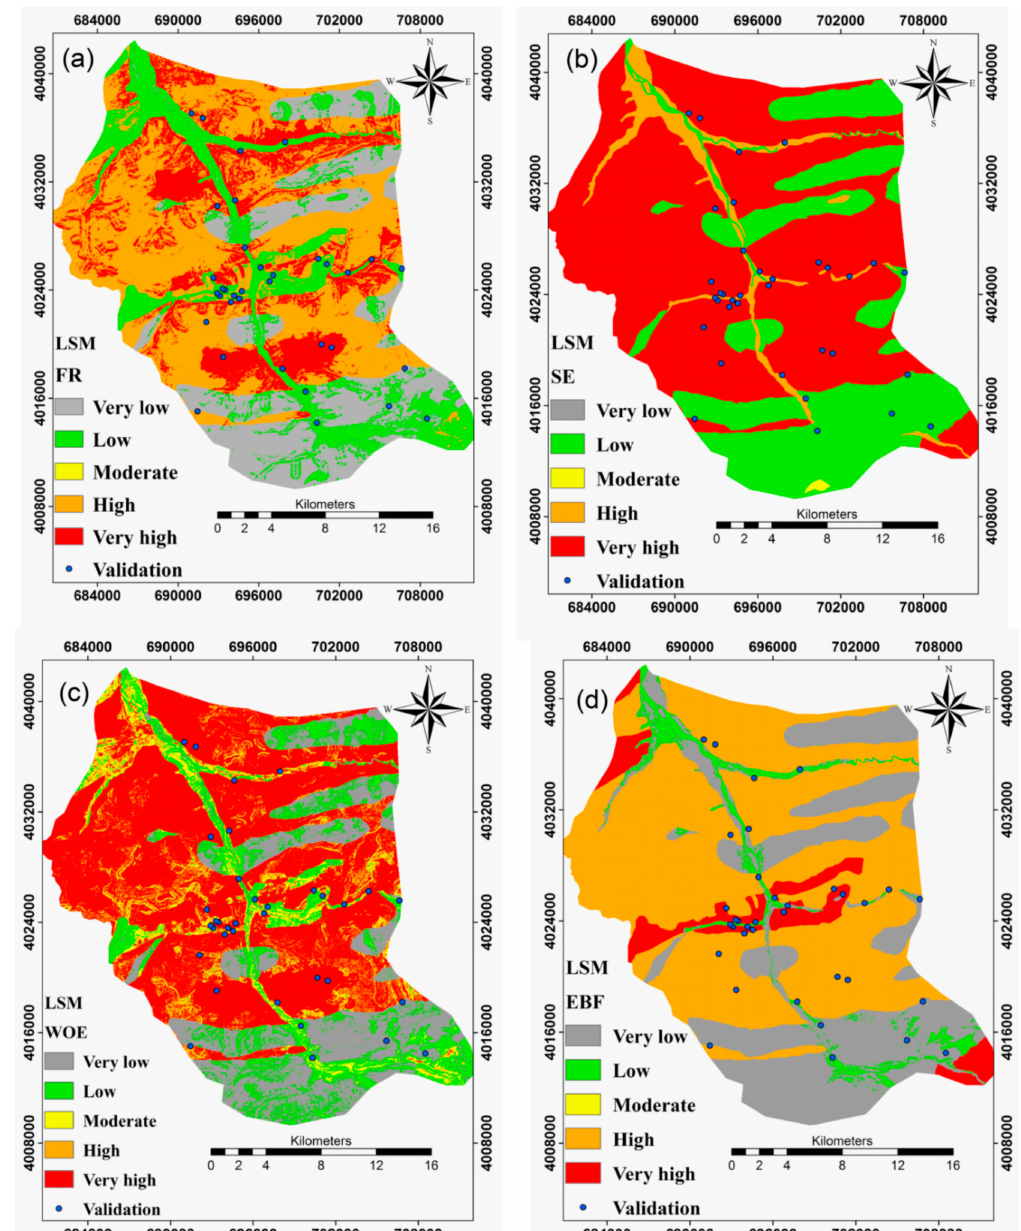
Figure 5. Landslide susceptibility maps produced by ( a ) FR, ( b ) SE, ( c ) WoE, and ( d ) EBF